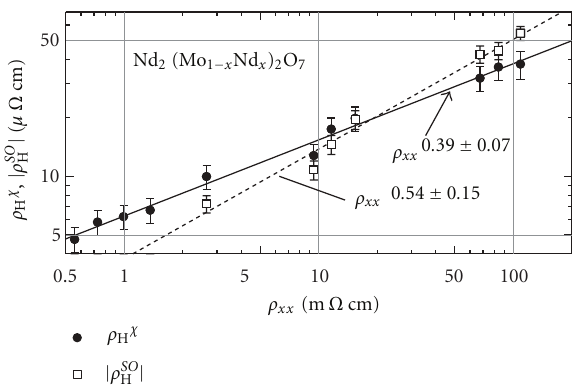
Figure 5: A plot of the relationship in Nd 2 (Mo 1 − x Nb x ) arising from the spin chirality, ρ χ